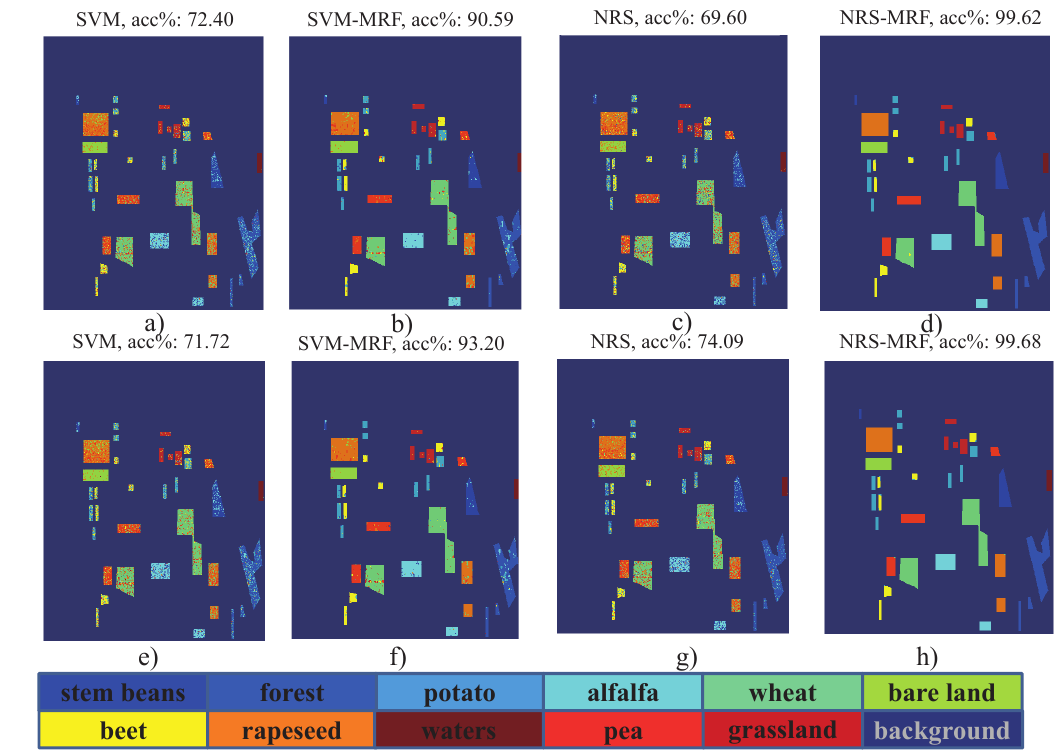
Figure 6. The classification results for Flevoland I data: ( a – d ) classification with 49 features; ( e – h ) classification with 79